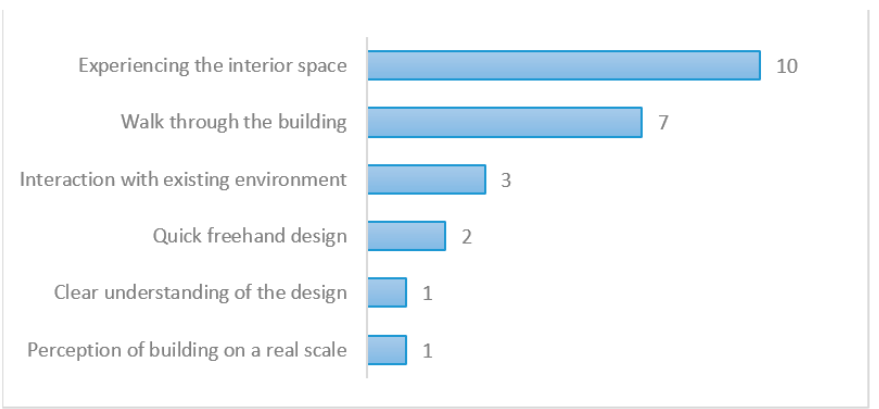
Figure 10. The most highly rated advantages of using IVR in design, according to teachers.